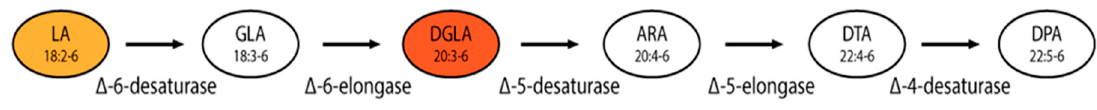
Figure 1. Desaturases involved in the biosynthesis of omega 6 polyunsaturated fatty acids. LA: linoleic acid; GLA: γ -linoleic acid; DGLA: dihomo- γ -linolenic acid; ARA: arachidonic acid; DTA: docosatetraenoic acid; DPA: docosapentaenoic acid. ∆ 6 desaturase is responsible for the formation of the carbon-carbon double bonds, and the function of an elongase is to lengthen fatty acid chains by the addition of two carbon units. LA (18:2-6) is desaturated by a ∆ 6 desaturase, introducing a D6 double bond into the substrate, giving γ -linolenic acid (GLA, 18:3-6). GLA is then elongated by a ∆ 6 elongase to dihomo- γ -linolenic acid (DGLA, 20:3-6). Modified from: Meesapyodsuk & Qiu, 2012 [25].